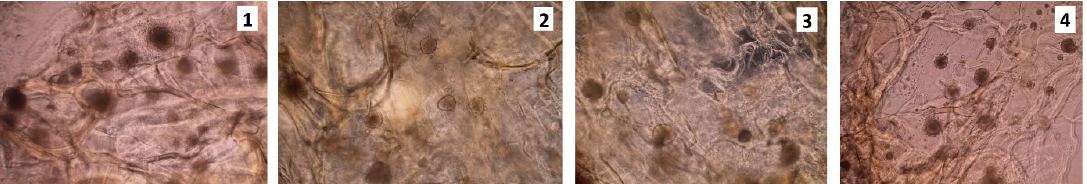
Figure 8. HCT116 cell culture on the scaffolds sterilized with ethylene oxide, rinsed in PBS with the addition of antibiotics; 7th day of the cell culture (sample 1—chitosan crosslinked with adipic and malonic acid; sample 2—chitosan crosslinked with adipic and L -glutamic acid; sample 3—chitosan crosslinked with adipic, L -glutamic and malonic acid; sample 4—chitosan crosslinked with adipic and levulinic)